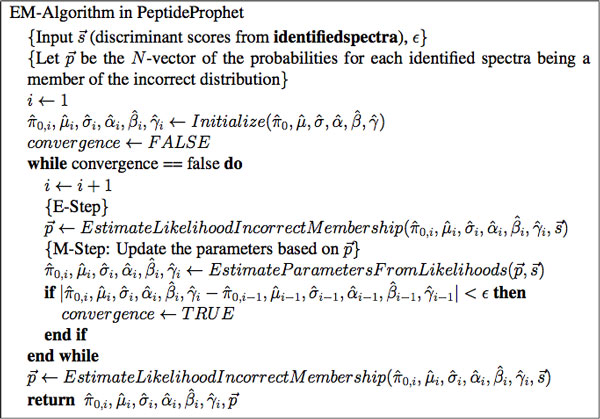
Pseudocode of the EM-algorithm for iteratively estimating model parameters and membership probabilities.